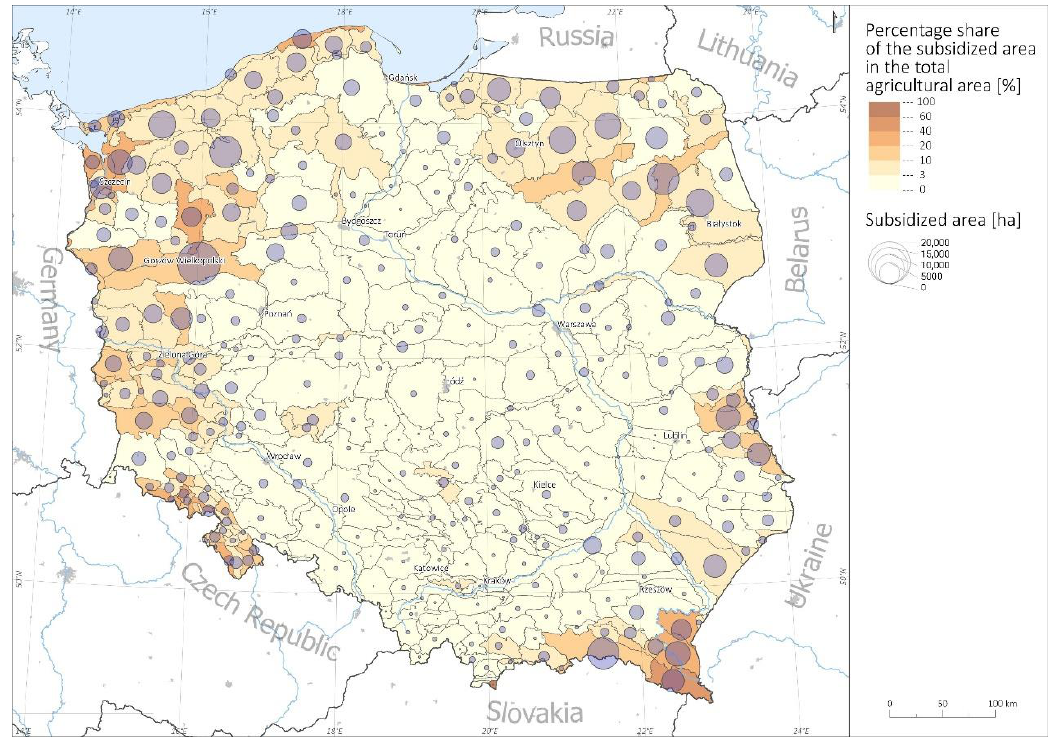
Figure 2. Area and share of agricultural land subsidised under the support of nature value habitats according to the RDP 2014–2020 agri-environment-climate measure in physico-geographical mesoregions (Source: Authors).